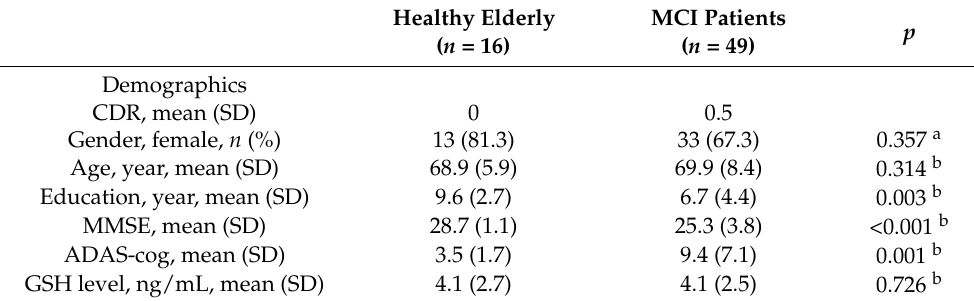
Table 1. Demographic characteristics of the overall cohort ( n = 65) at